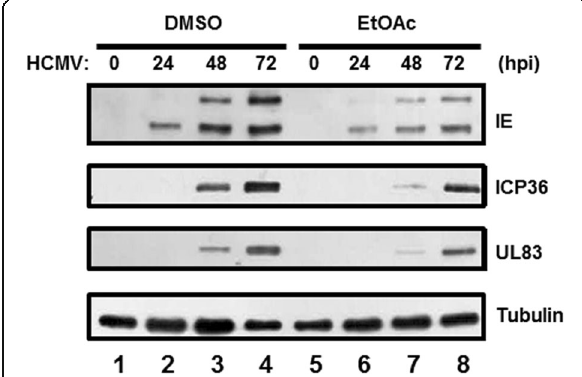
Fig. 5 Downregulation of HCMV lytic gene expression by the EtOAc fraction of ESE. HFF cells were infected with HCMV-Towne at an MOI of 1 and treated with either DMSO or the EtOAC fraction of ESE (50 μ g/ml). At 0, 24, 48 or 72 h after infection, equal amounts of cell extracts were subjected to western blot analysis with antibodies against HCMV IE (IE1-72 kDa and IE2-86 kDa), ICP 36, UL83 and